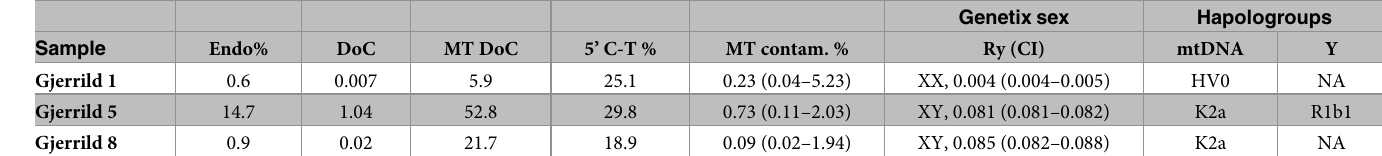
Table 2. Basic sequencing results.